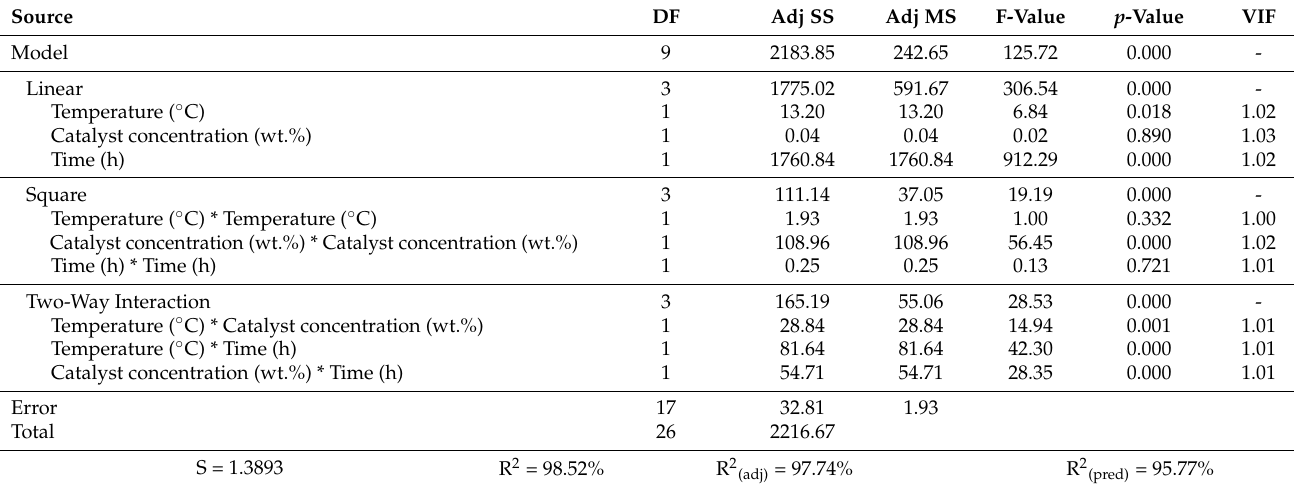
Table 3. Analysis of variance of thumbergol